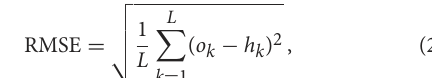
to MODFLOW 2005, as described in Gelsinari et al.